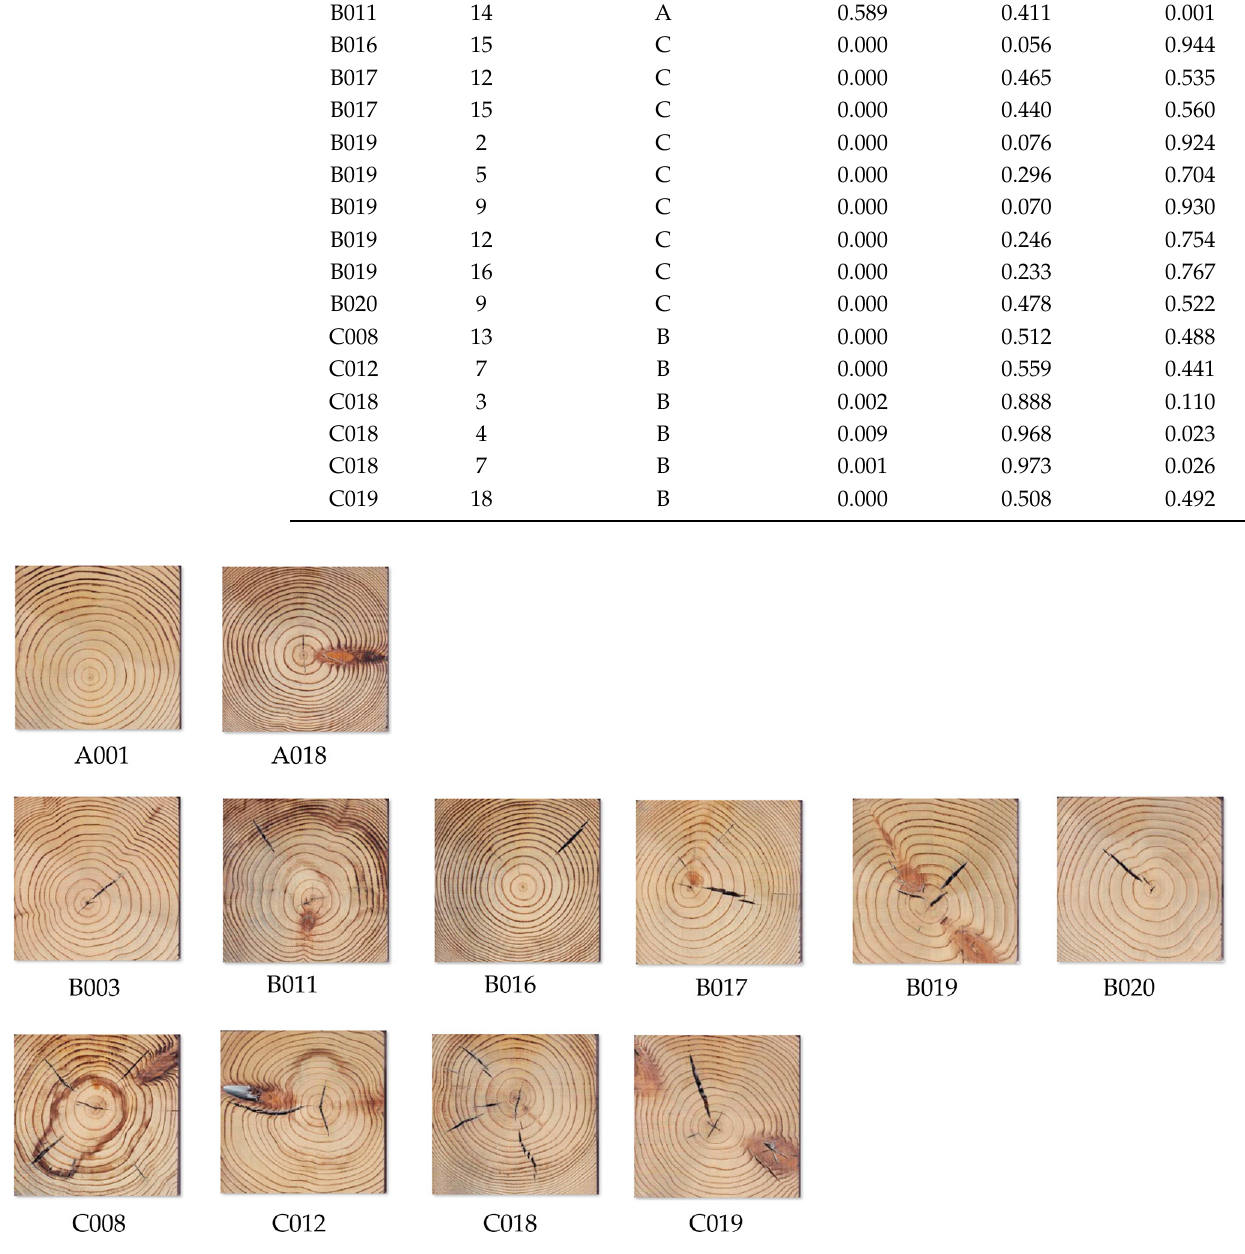
Figure 13. Misclassified images.